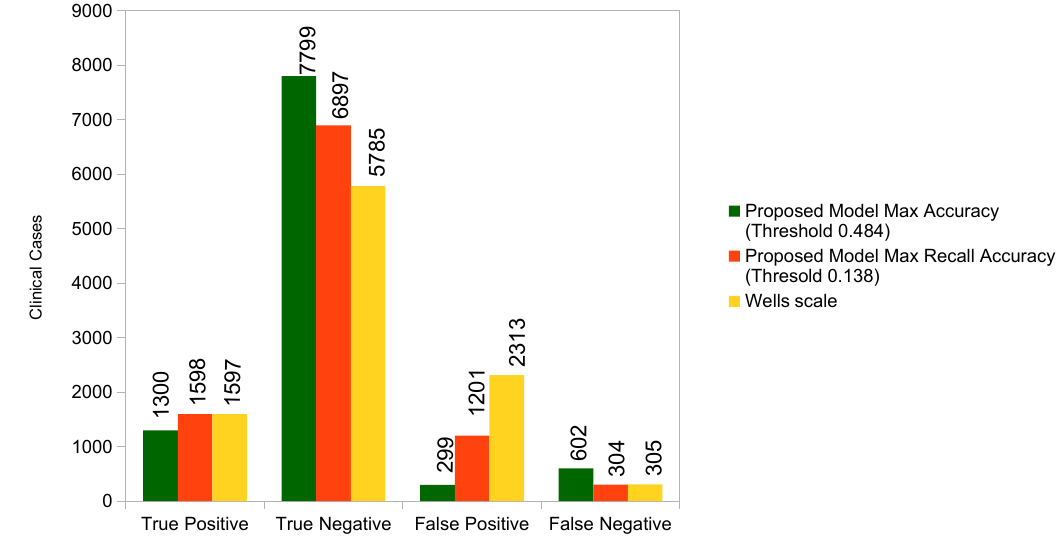
Figure 8. Comparison of the confusion matrices of the proposed ANN model.